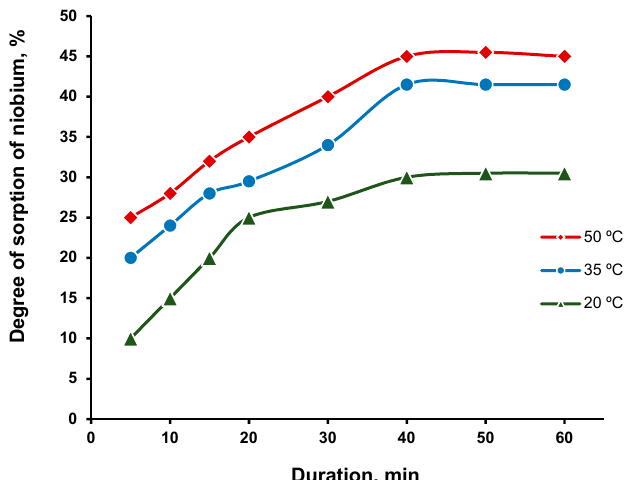
Figure 11. Influence of temperature on the niobium sorption degree by Purolite A-100 ion-exchange resin.